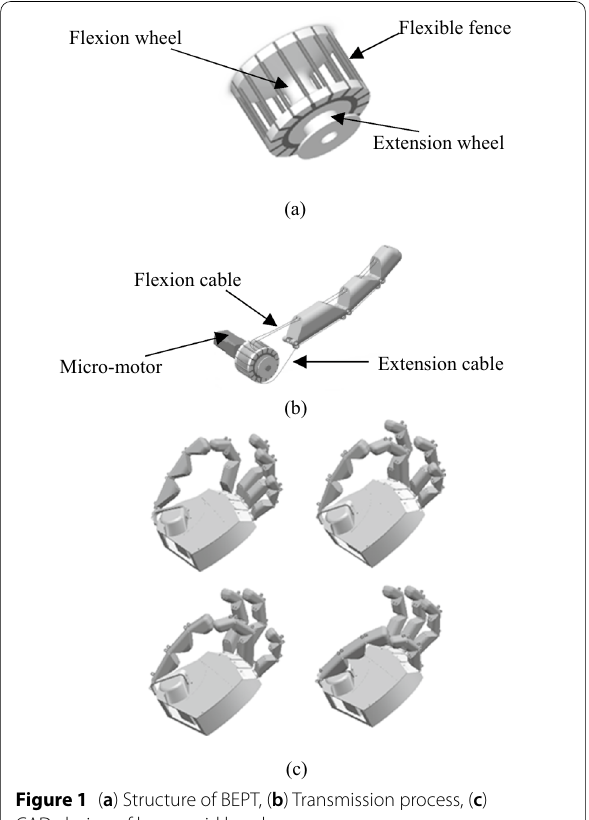
Figure 1 ( a ) Structure of BEPT, ( b ) Transmission process, ( c ) CAD-design of humanoid